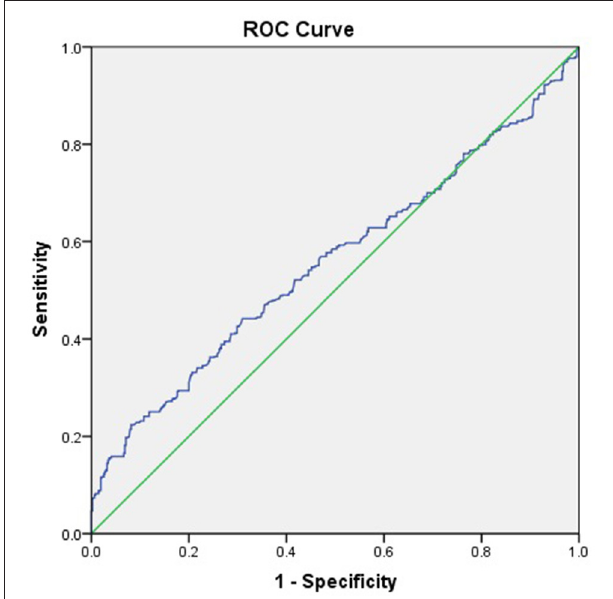
FIGURE 2 | ROC curve of CAD by serum complement C1q